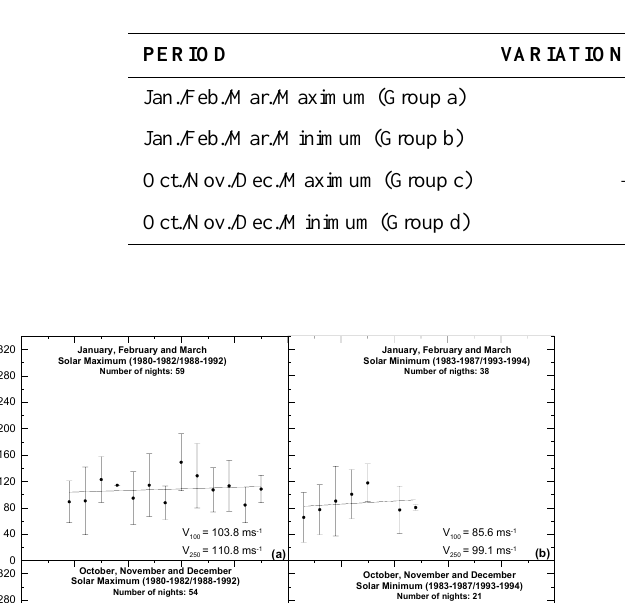
Table 3. Velocities’ variations with Solar Flux in Jy (where 1Jy=1Jansky=10 − 26 Wm − 2 Hz − 1 =10 − 4 Solar Flux Units F10.7cm obtained from Fig. 2.)